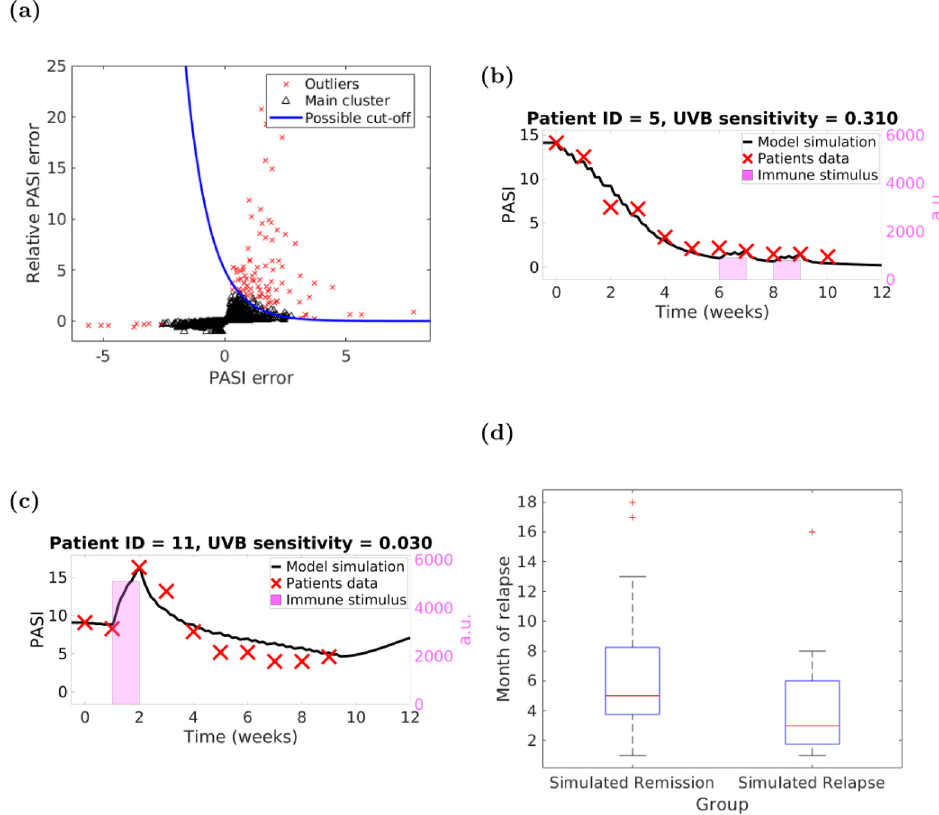
Fig 6. Our ODE model enables identification of psoriasis flares. Panels: (a)—distribution of relative PASI difference with respect to absolute PASI difference computed by DBSCAN with � = 0.5 and minimum number of points 20 (red crosses—outliers, and black triangles—main cluster) and a possible curve separating flares (all the points above the blue line) and PASI measurement errors (all point below the line); (b,c)—examples of fitting immune stimuli for two different patients, (d)—patient groups based on model predictions of psoriasis relapse: our personalised flares-enabled model predicts Remission (n = 49) and Relapse (n = 13) groups.